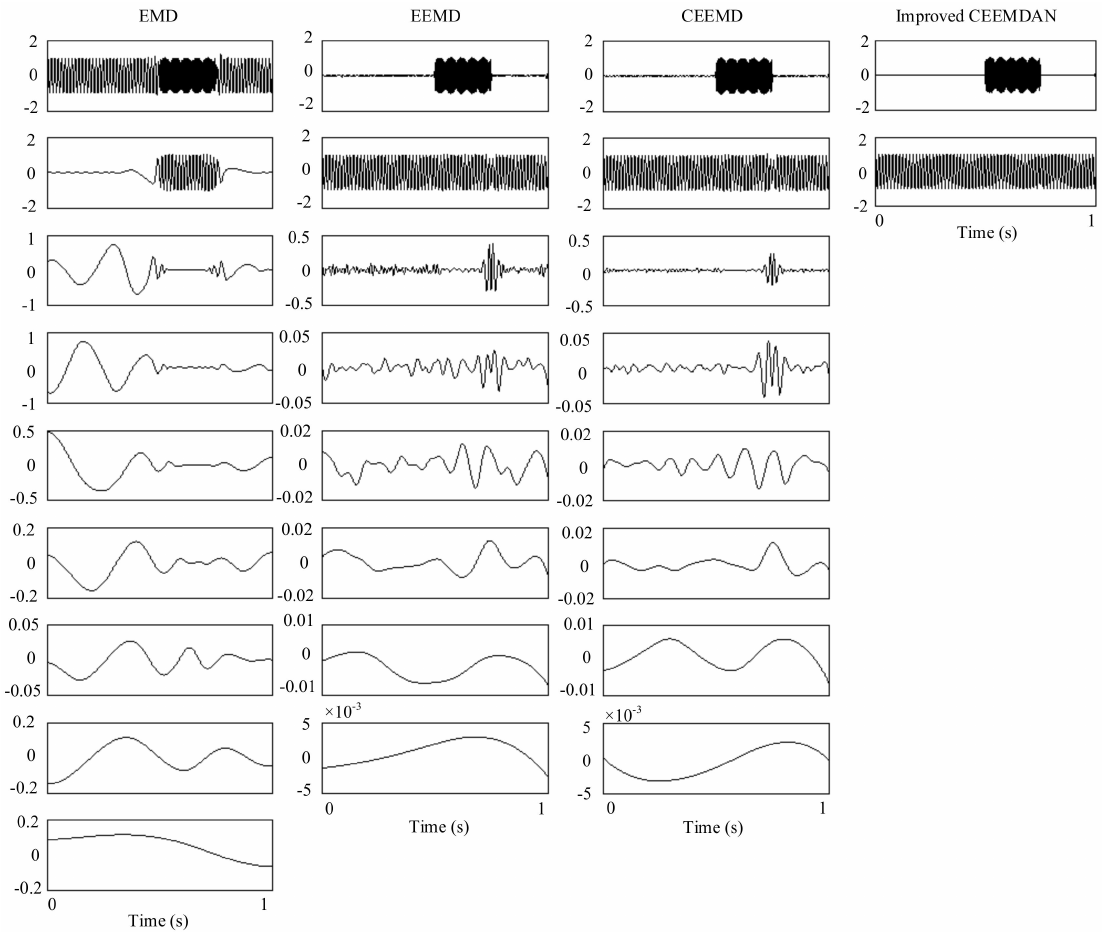
Figure 20. Comparisons among EMD, EEMD, CEEMD and improved CEEMDAN.